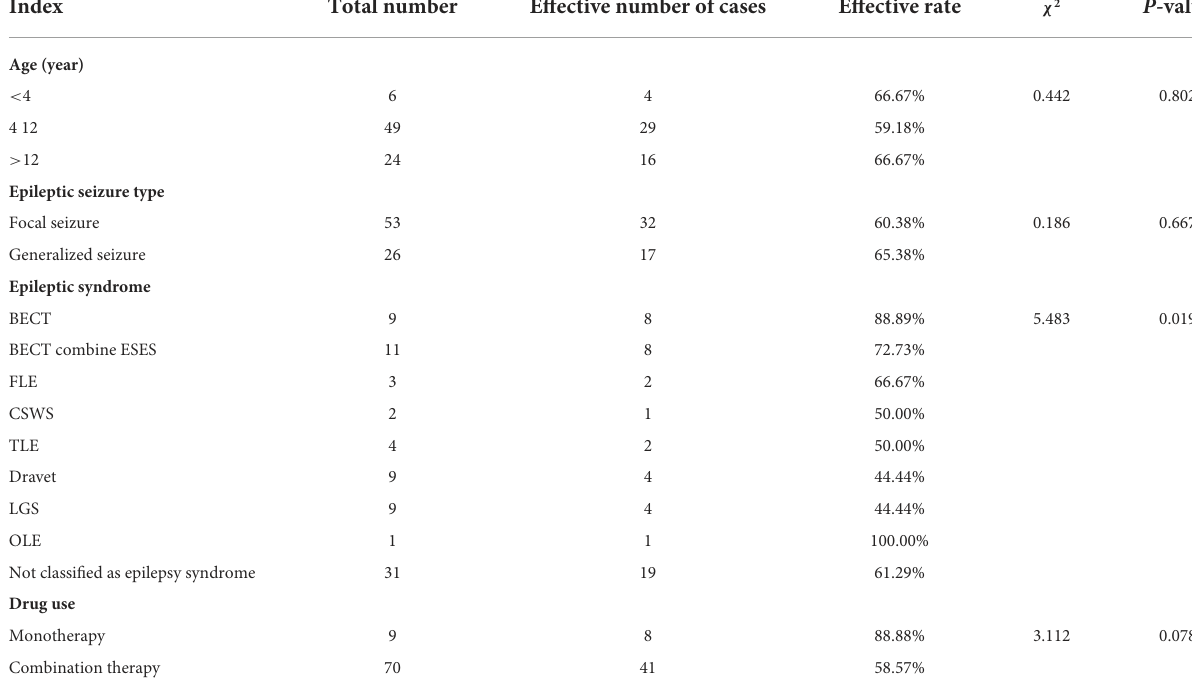
TABLE 2 Comparison of effective rates of different types of